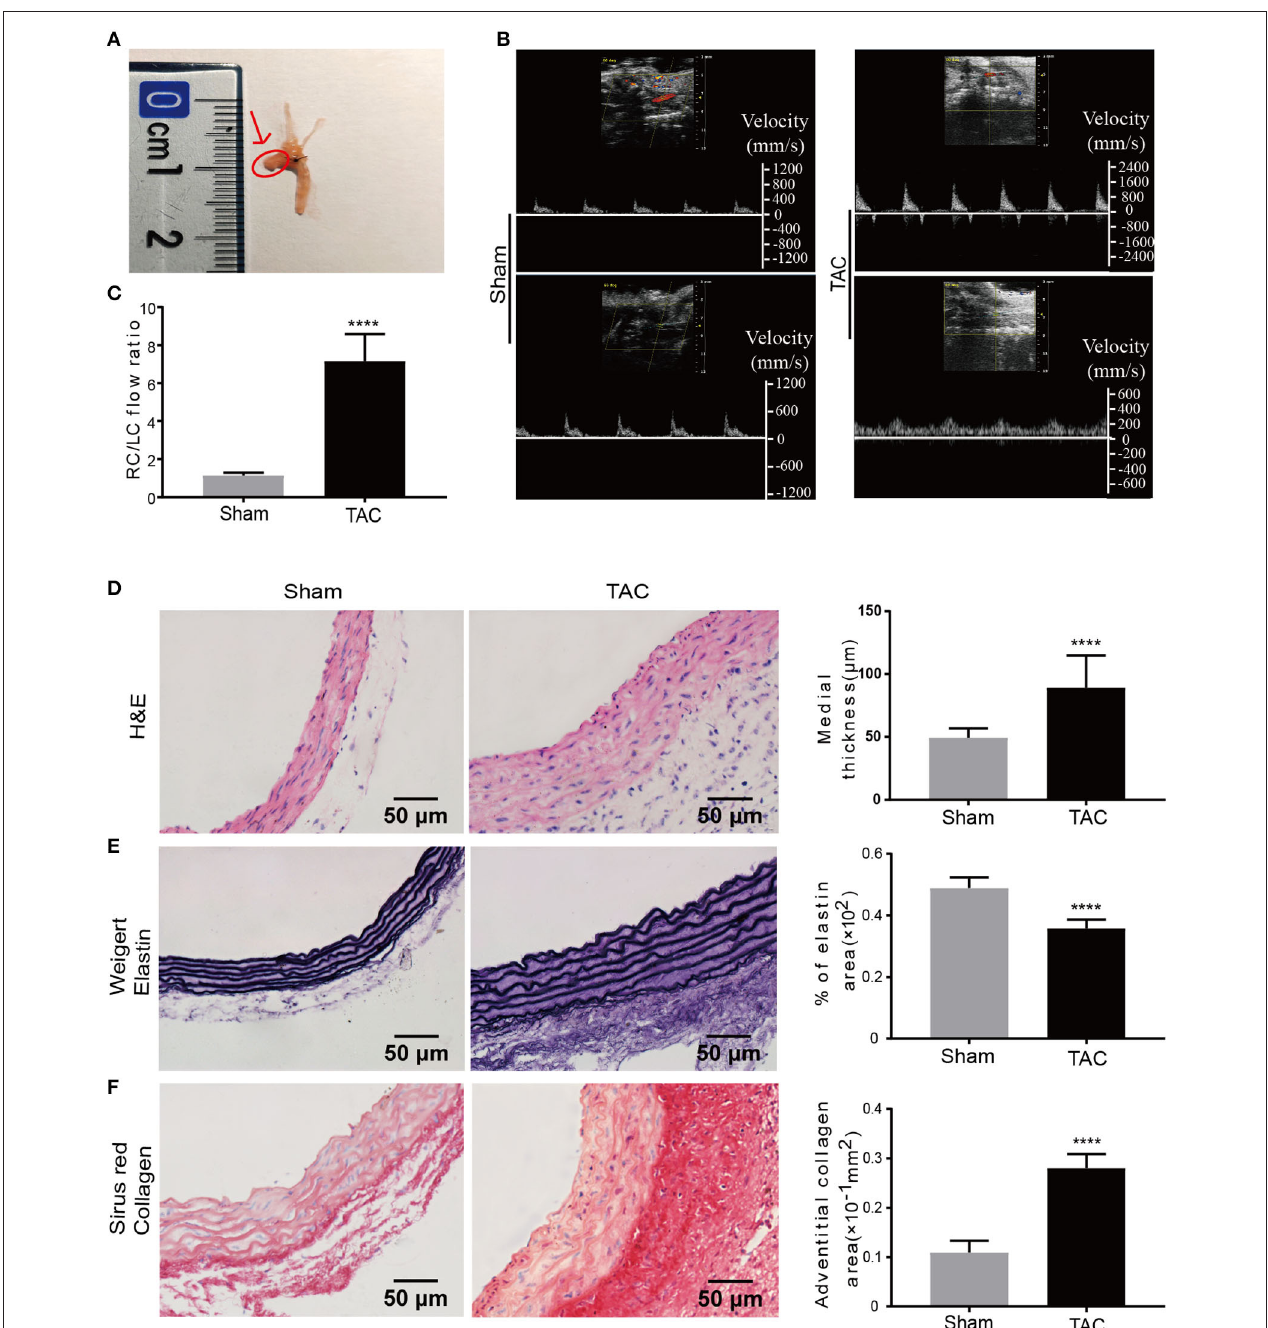
FIGURE 1 | Increased blood pressure and remodeling of the aortic wall in established TAC model. (A) TAC was constructed by ligation between the brachiocephalic trunk and LCCA. Tissues used for all analysis are indicated by the arrow and the red circle; (B) Blood flow velocity measurement at RCCA and LCCA of the sham or TAC groups, respectively; (C) Right carotid /left carotid (RC/LC) flow ratio of TAC and sham group; (D–F) Representative images and quantification analysis of hematoxylin and eosin (H&E) staining (D) , Weigert’s staining (E) , and Sirius red staining (F) ; n = 6 per group. Original magnification: × 400. **** P <